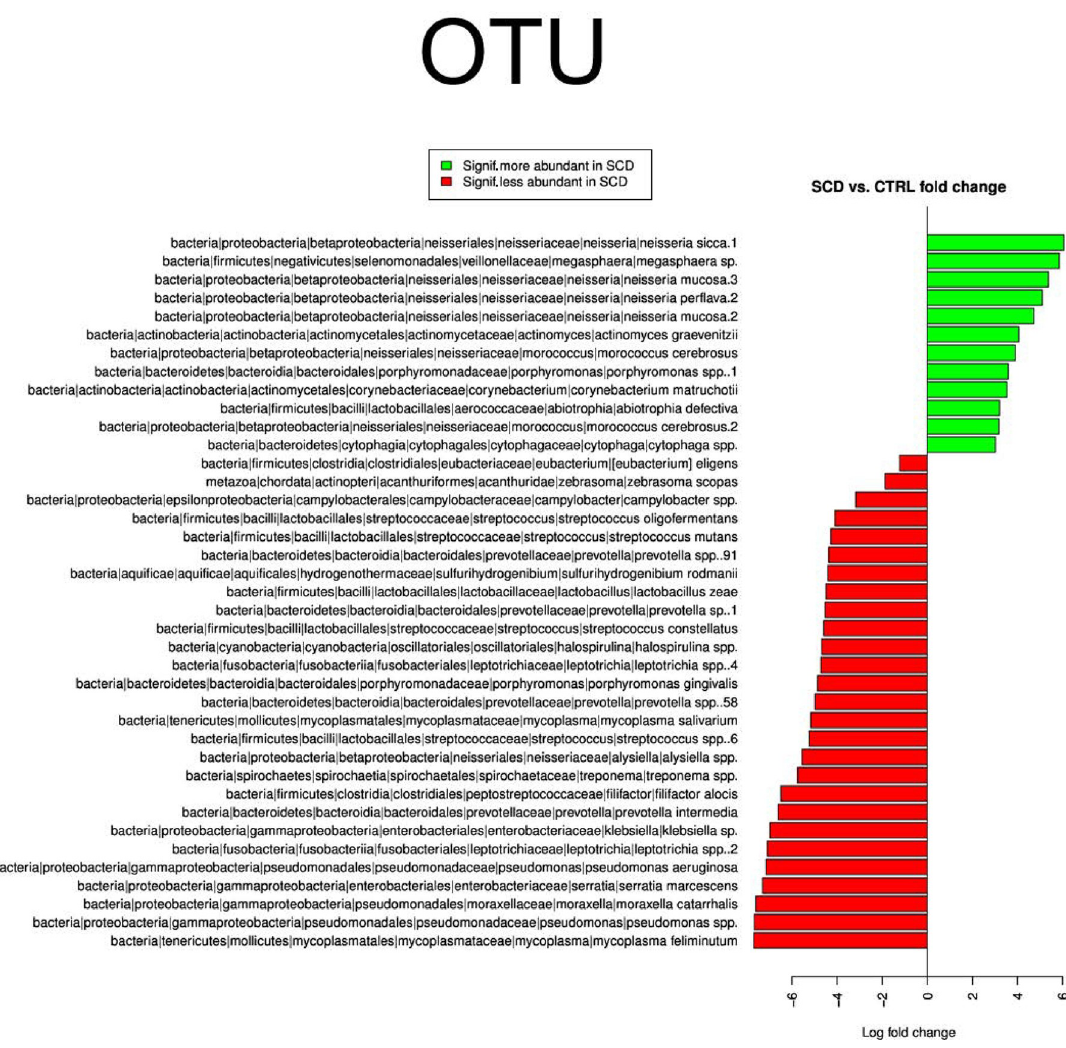
Fig 4. Differential OTUs between SCD subjects and healthy controls’ saliva